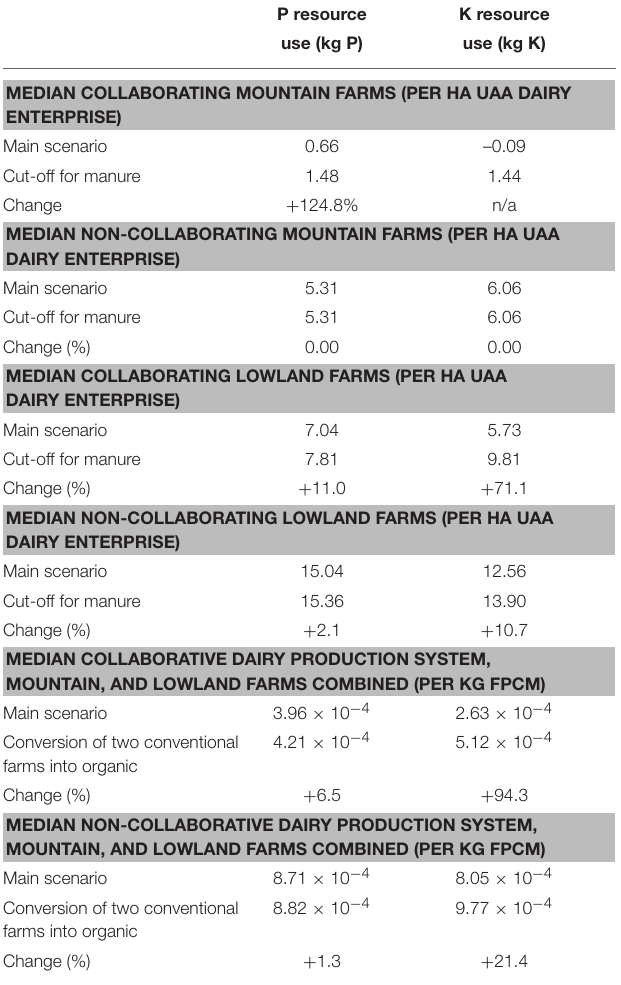
TABLE 3 | Sensitivity analysis: cut-off approach for manure applied outside of the dairy enterprise, in which emissions from manure application lay outside of the scope of the dairy enterprise (cut-off for manure), compared to the original scenario, in which credits for mineral fertilizers replaced by manure were applied (main scenario) for the impact categories affected the most by this change (P resource use, K resource use).